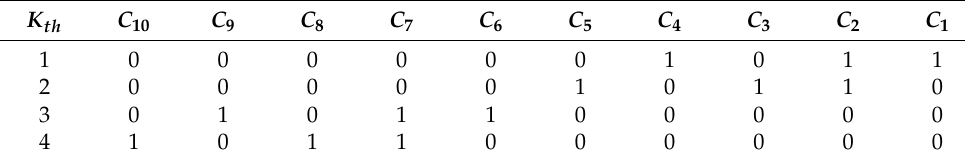
Table 4. FDW code sequence for W = 3.